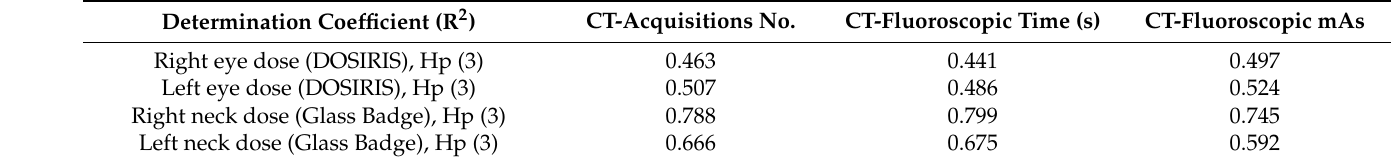
( a ) ( b ) Figure 3. Relationship between the eye dosimeter measurements (DOSIRIS, Hp (3)) inside and outside the Pb eyeglasses, taken monthly during CTF-guided biopsies (47 procedures). ( a ) Right side dosimeter; ( b ) left side dosimeter. Table 4. Determination coefficient (R 2 ) between physician doses and CT dose-related parameters (95 procedures).